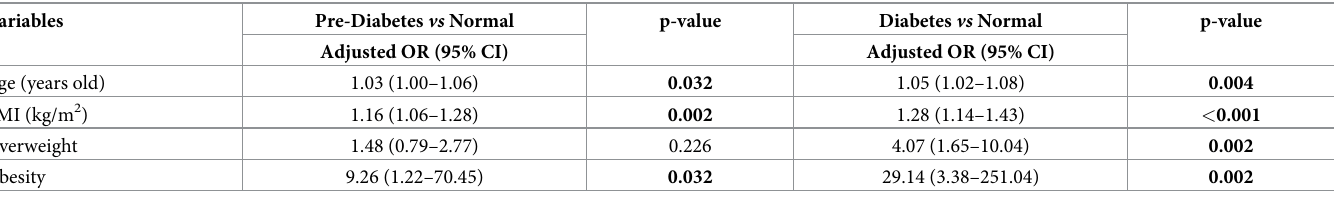
Table 3. Odds ratio adjusted for gender and age and confidence interval (CI) for sociodemographic and anthropometric variables, clinical factors, habits and life- style and family history associated with pre-diabetes and diabetes among the Munduruku indigenous people.